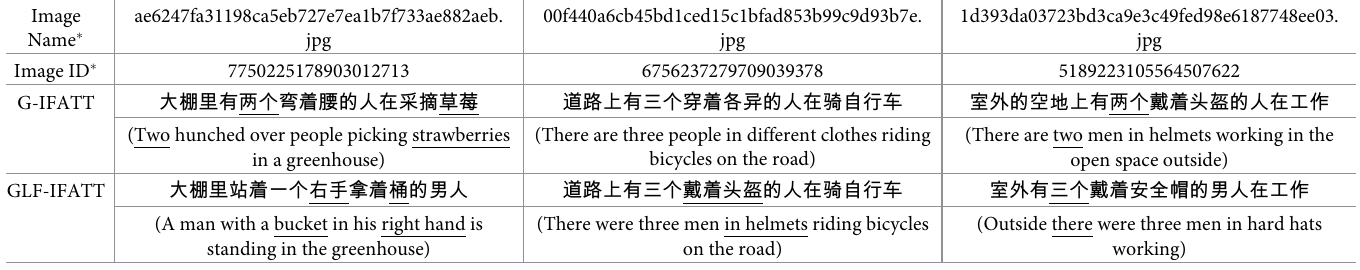
Table 6. Subjective comparison of description